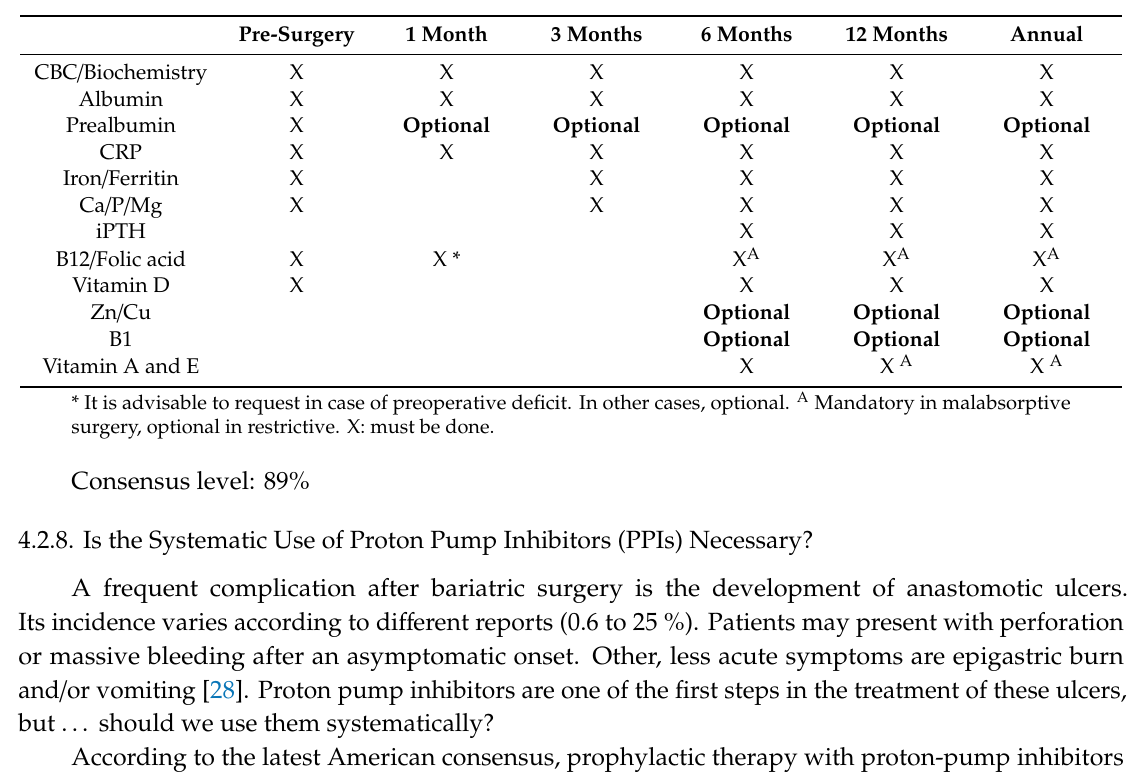
Table 5. Follow-up analytical